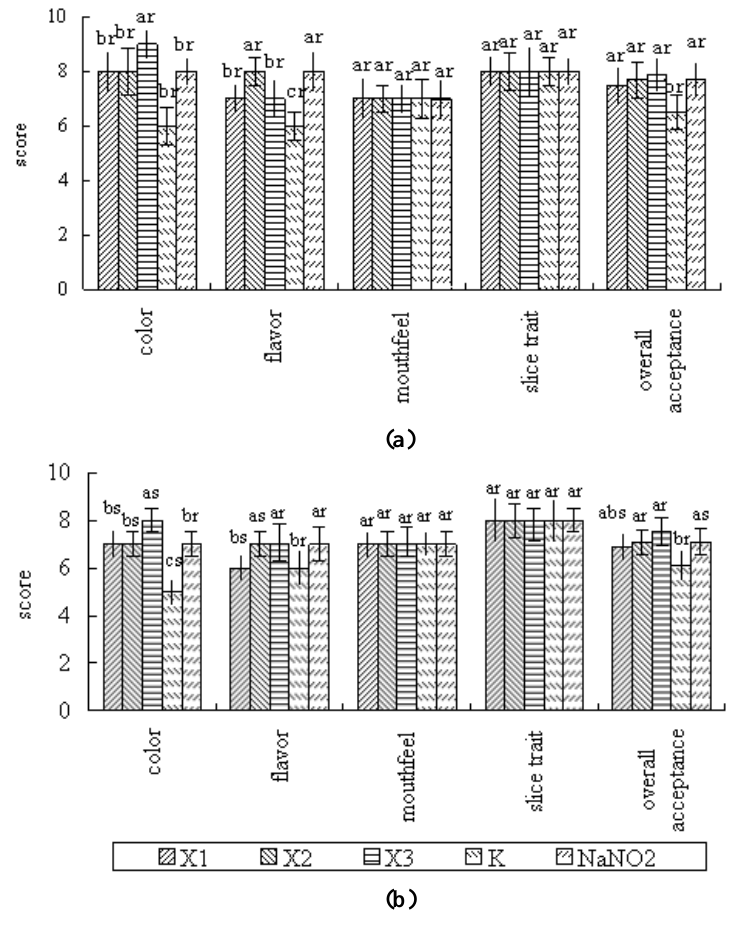
Figure 4. The changes in sensory qualities of pork sausages during storage. (a) The changes in sensory qualities of pork sausages during 1st d; (b): The changes in sensory qualities of pork sausages during 29th d. X1, X2 and X3 stand for the samples with 0.1%, 0.2% and 0.3% Amaranthus pigments addition, respectively; K stands for the controls, NaNO 2 stands for the samples with 0.015% NaNO 2 addition. Means  SD within the column having unlike letters (a to c) means that the five treatments are significantly different (p<0.05) at the same storage time. Means  SD within the row having unlike letters (r to s) means that the same treatment are significantly different (p<0.05) at the different storage